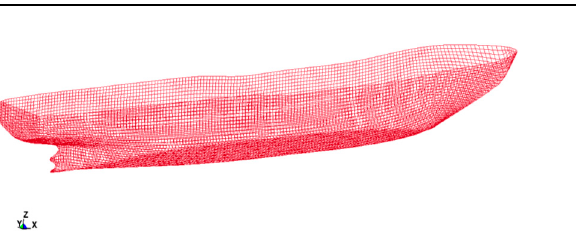
Figure 7. The numerical model used as a reference ship in the icebreaking simulations. Table 5. Primary dimensions of MV Xue Long.